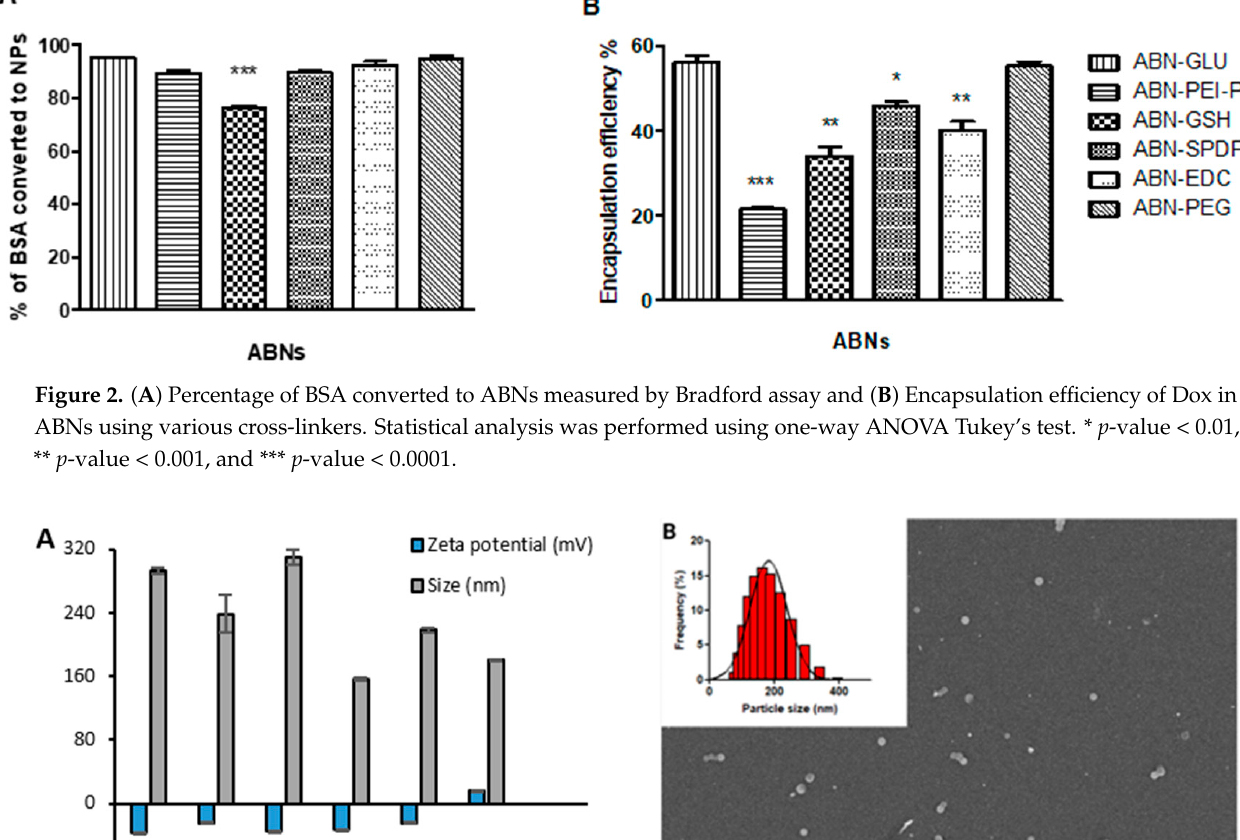
Figure 2. ( A ) Percentage of BSA converted to ABNs measured by Bradford assay and ( B ) Encapsulation efficiency of Dox in ABNs using various cross-linkers. Statistical analysis was performed using one-way ANOVA Tukey’s test. * p -value < 0.01, ** p -value < 0.001, and *** p -value < 0.0001.